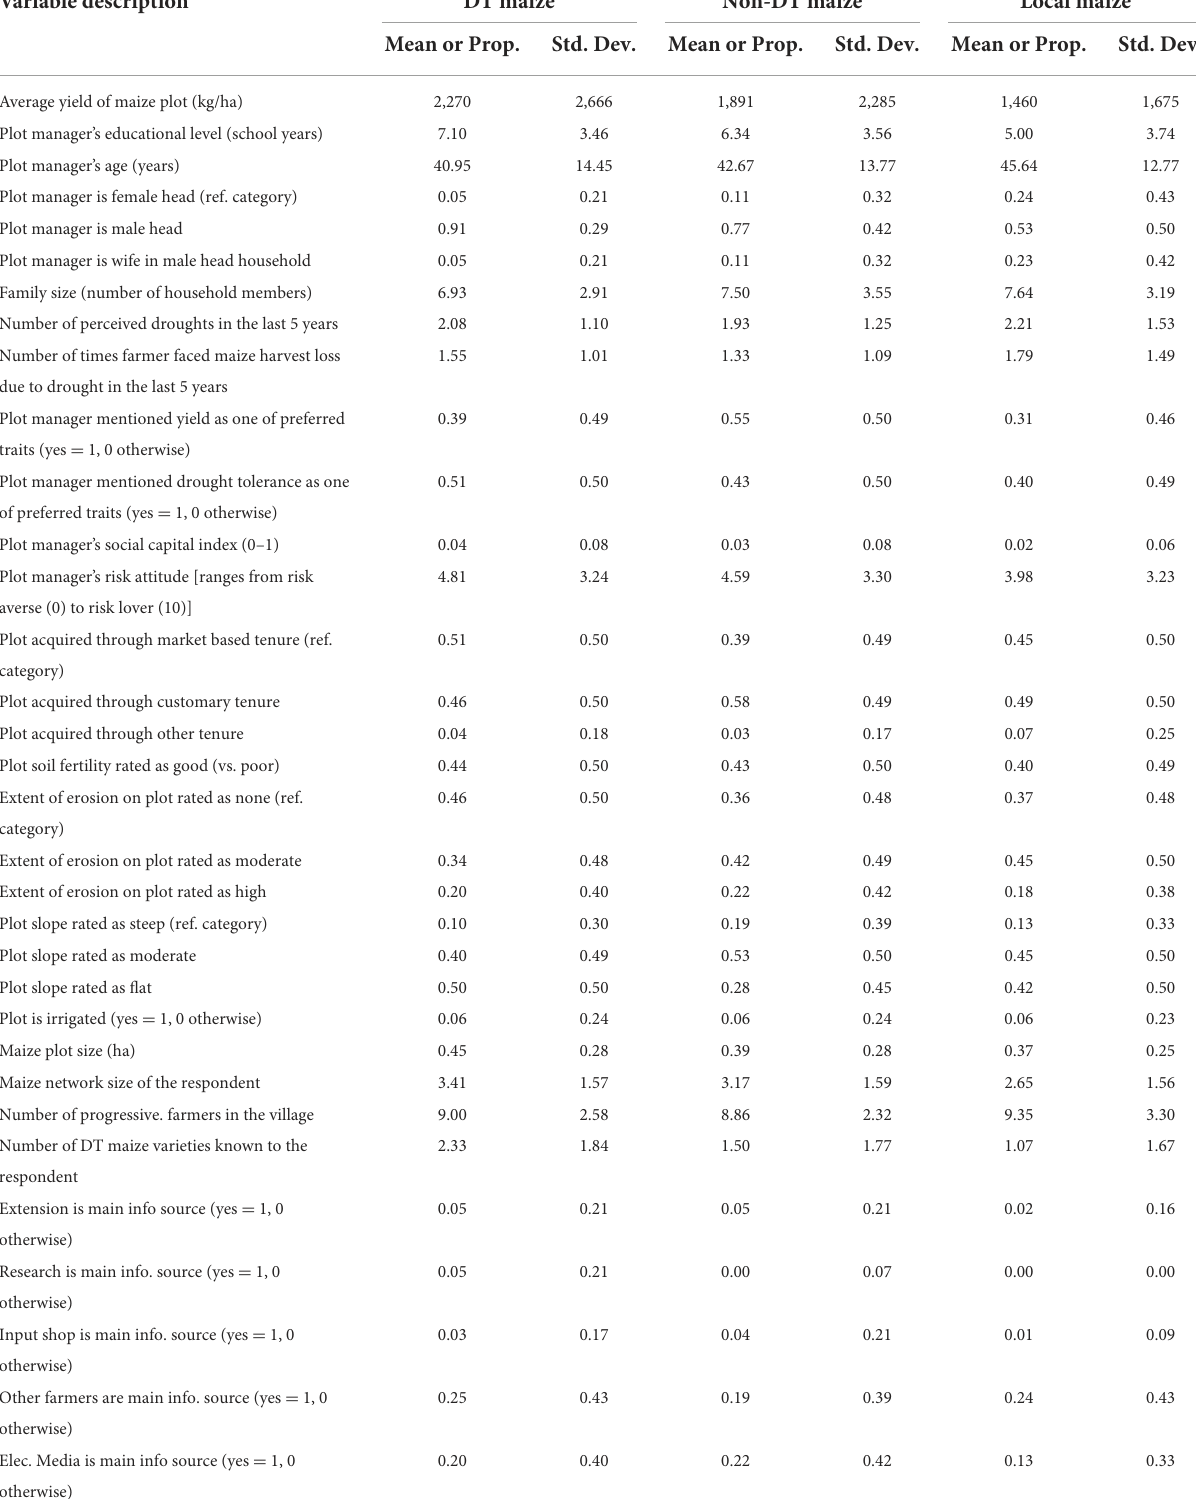
TABLE 2 Descriptive summary of selected variables used in estimations. Variable description DT maize Non-DT